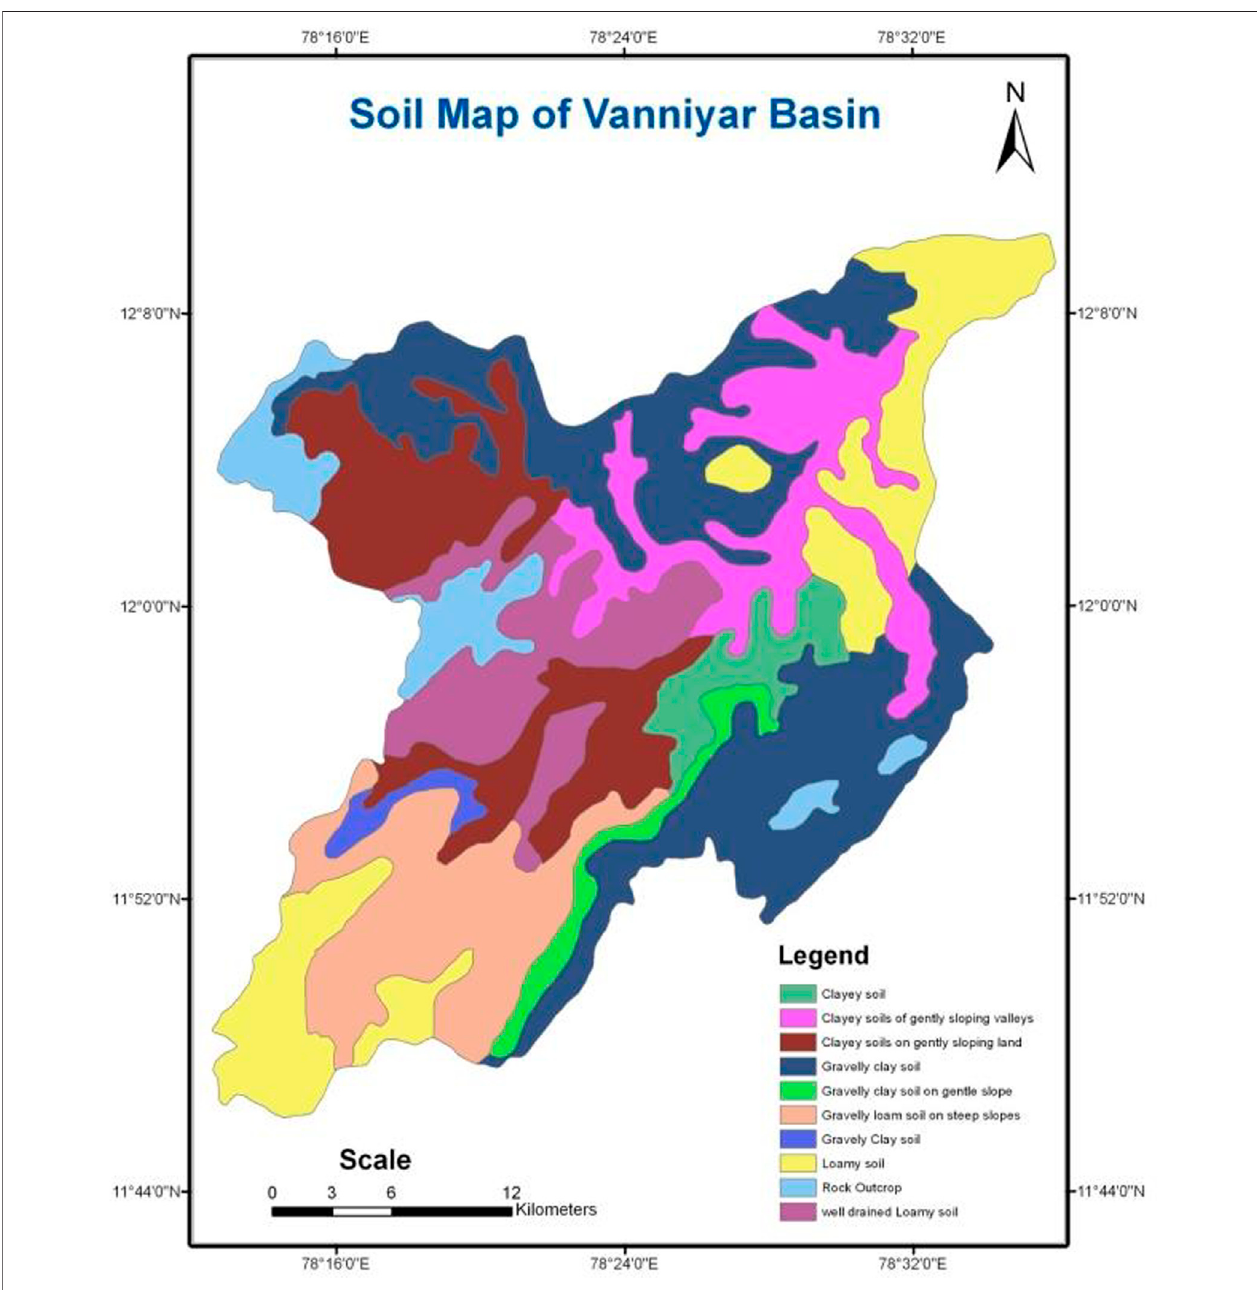
FIGURE 5 | Soil map of the Vanniyar basin, Dharmapuri district, Tamil Nadu, India.